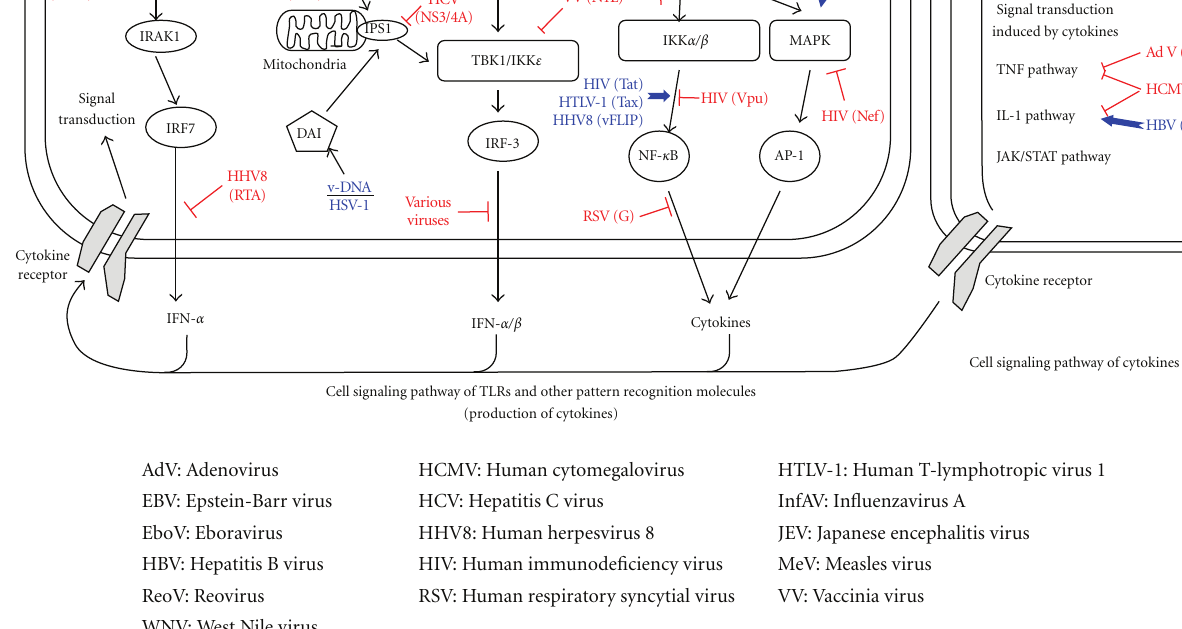
Figure 2: Modulation of TLR and other PAMP-induced signal transduction pathways by virus infection. Red line indicates suppression by virus. Blue line indicates activation by virus. Parenthesises denote viral proteins ornucleic